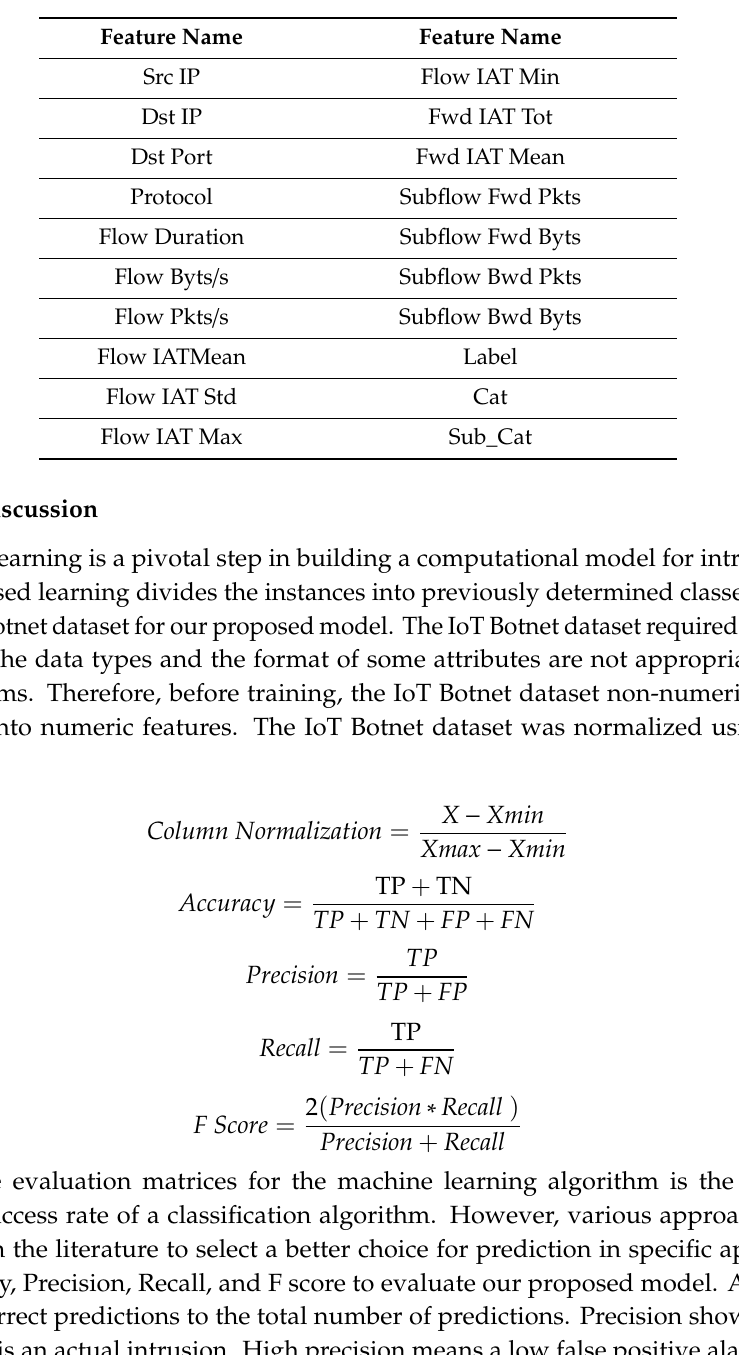
Table 4. Selected Flow Features IoT Botnet